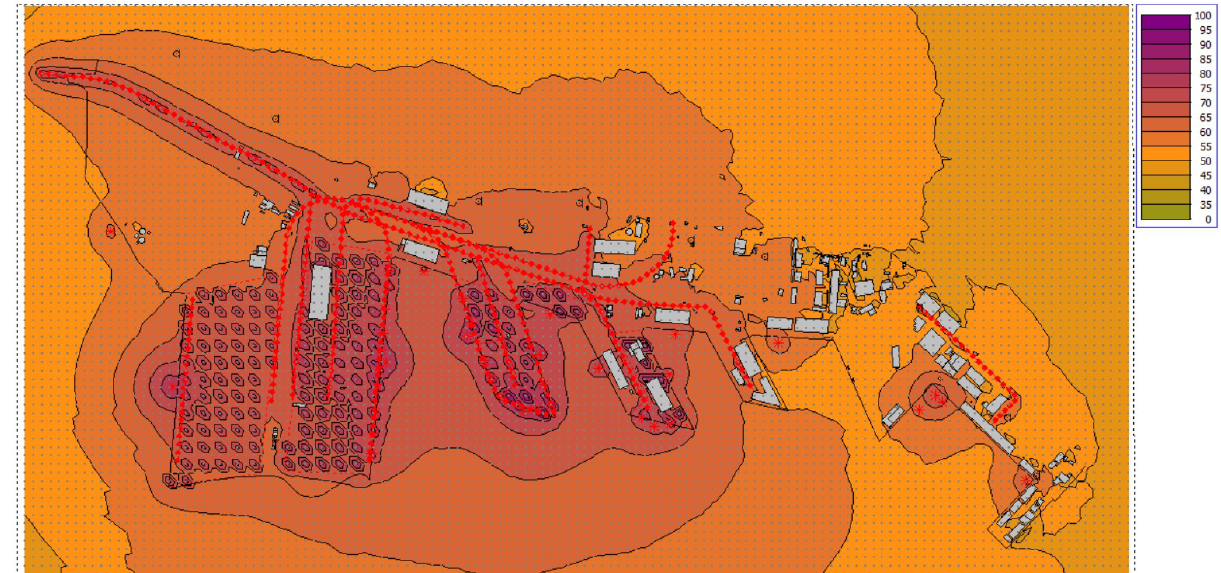
Figure 4: Noise map of the Port of Thessaloniki for the most common wind conditions